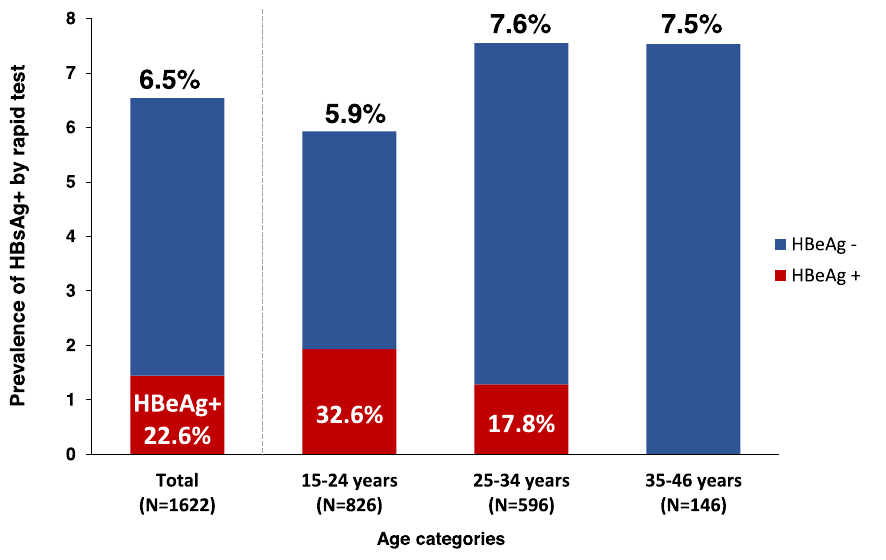
Figure 2. Prevalence of HBsAg and HBeAg in pregnant women in Yako, rural Burkina Faso. HBsAg was screened by rapid diagnostic test (RDT) in 1622 pregnant women visiting the study centers for antenatal care, and 106 were positive. Of the 106 HBsAg-positive by RDT, 105 DBS samples were available for serological analyses. 102 DBS samples were positive for HBsAg by CLEIA in DBS samples and underwent HBeAg measurement. The numbers on top of each graph indicate the HBsAg prevalence, while the numbers inside each bar represent the corresponding HBeAg